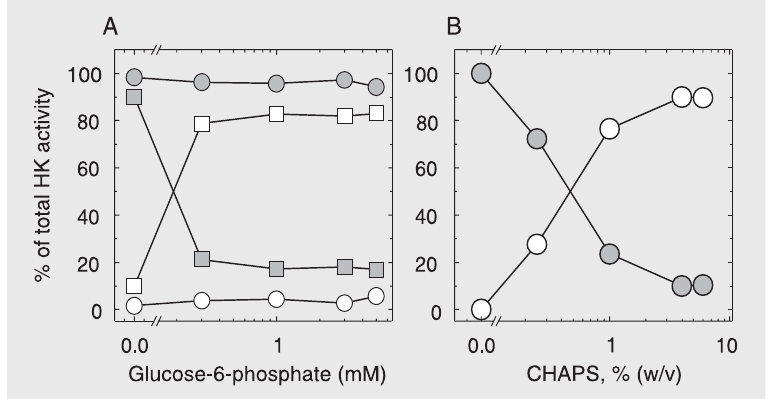
Figure 1. Solubilization of mitochondrial hexokinase (HK) activity with glucose-6-phosphate and CHAPS. A , Rat brain HK (squares) and maize roots HK (circles) from mitochondria incubated with glucose-6-phosphate. B , Maize root mitochondria incubated with CHAPS (% as w/v). The total HK activity is the sum of the supernatant (open symbols) and the pellet (filled symbols). The figure presents representative experiments from six mitochondrial preparations.